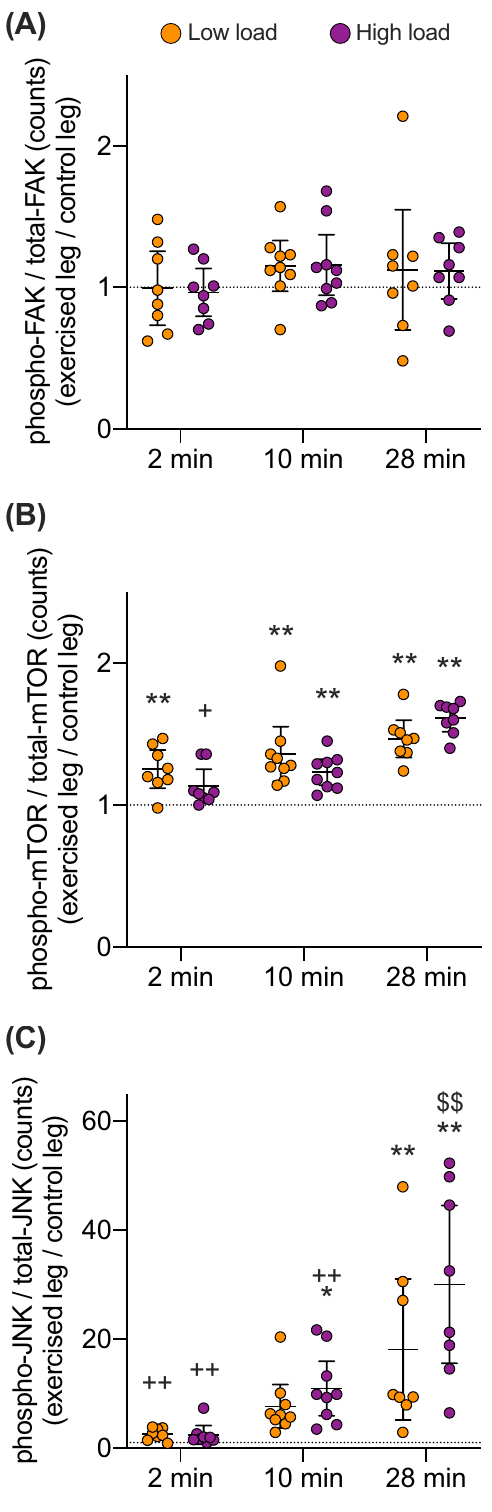
Figure 3. mTOR and JNK phosphorylation is increased with exercise duration, and for JNK also in a load- dependent manner. Specific phosphorylation of Y397-FAK ( a ), pS2448-mTOR ( b ) and pT183/Y185-JNK ( c ) shown as fold change in exercised relative to their respective contralateral control TA muscles after 2, 10 and 28 min of exercise with a high or a low load. Post-hoc significant differences denoted with *,** p < 0.05 and 0.01 versus control leg; + , ++ p < 0.05 and 0.01 versus 28 min exercise within loading groups; $$ p < 0.01 versus low load exercised group after 28 min of exercise. Data are presented as individual muscle values (circles) and group means with 95% CI (n = 8 per group for the 2 min and 28 min protocol, n = 9 per group for the 10 min protocol). Dotted line at y = 1 representing no difference between exercised leg and contralateral control